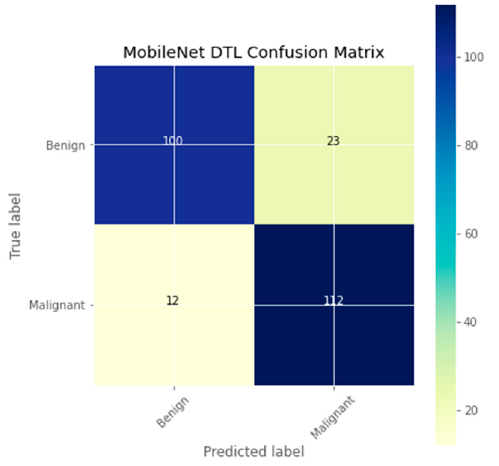
Figure 9. Confusion matrix of the DenseNet121 model.